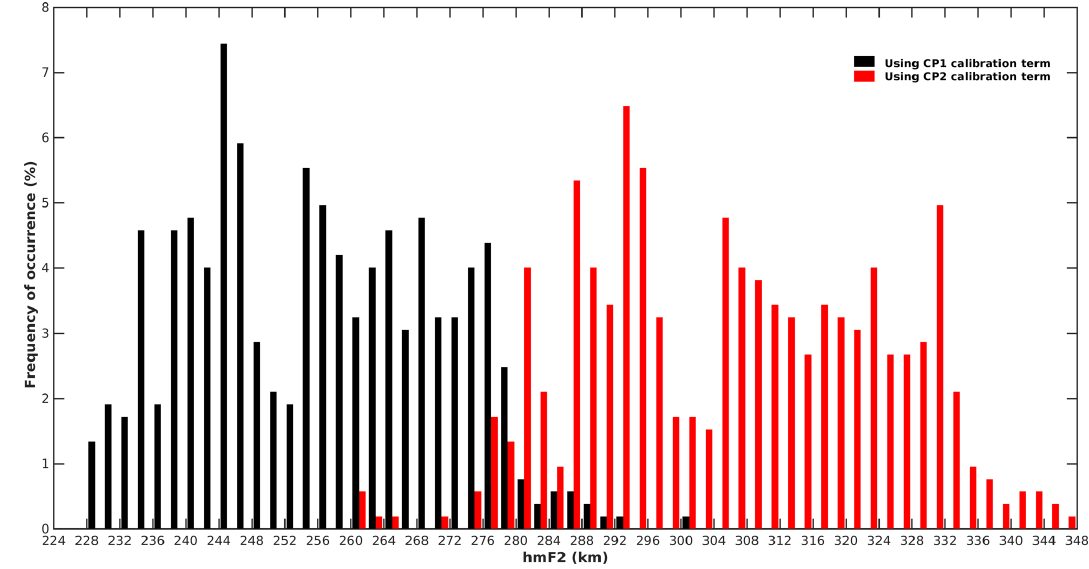
√ I 7774 and I 6300 .